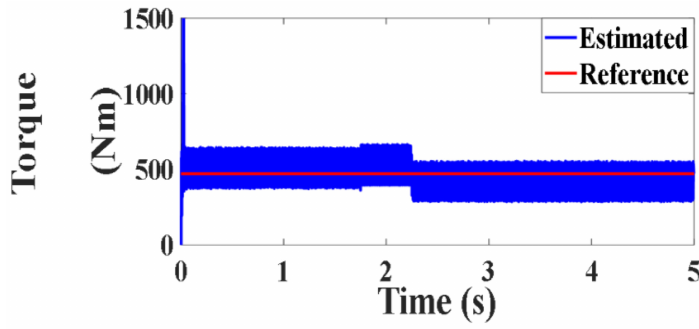
Figure 40. Torque under MPDTC